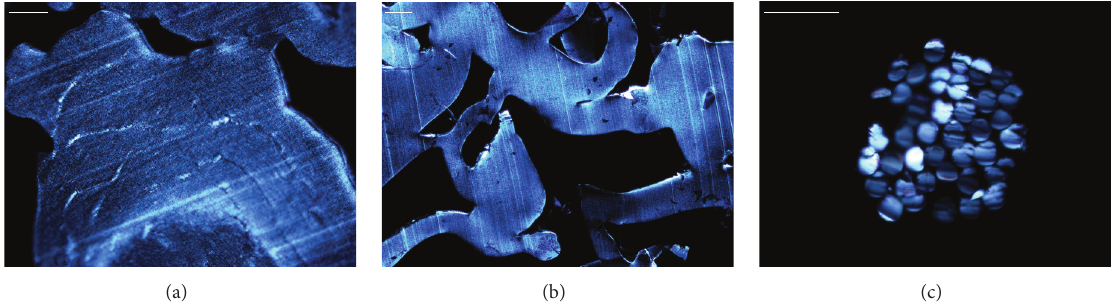
Figure 3: Histological evaluation under polarized light at 90 days after orbital implantation. Orbital implants MEDPOR, OCULFIT I, and OCULFIT II appeared as birefringent intraocular solid material adjacent to the internal surface of the sclera ((a), (b)). Birefringent cylindrical units were present in the peripheral adipose tissue (c). Scale bars: 20 𝜇 m ((a), MEDPOR; (c)) and 50 𝜇 m ((b), OCULFIT II).